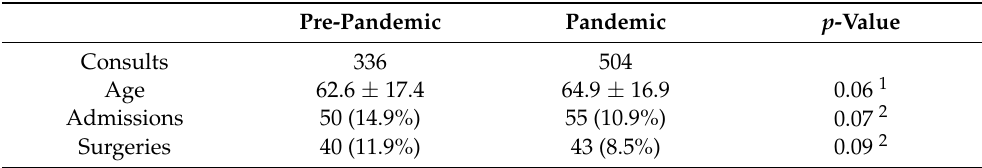
Table 1. Sample characteristics.